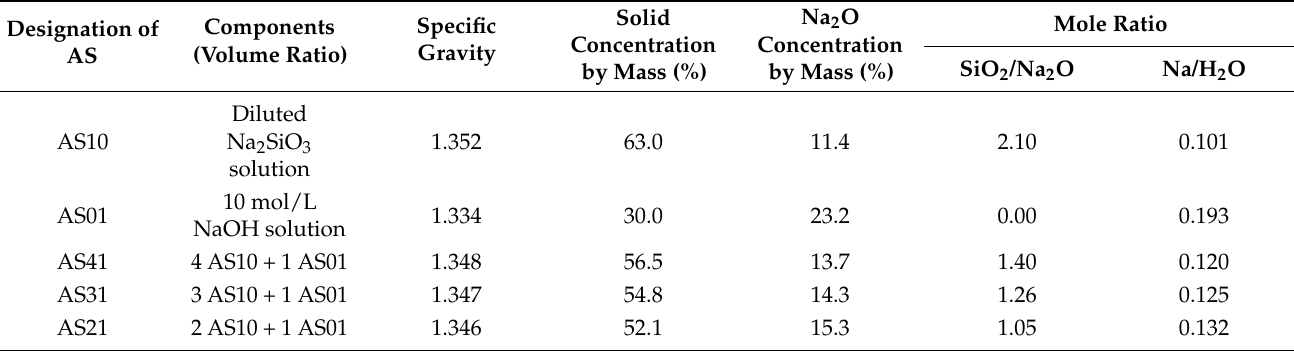
Table 2. Characteristics of alkali activator solutions